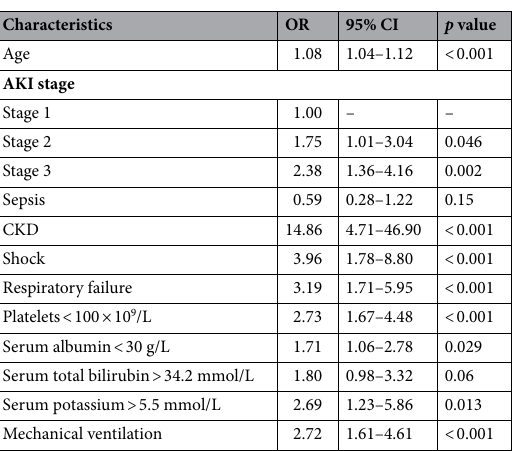
Table 4. Multivariable logistic regression analysis of risk factors associated with 90-day adverse outcomes. OR odds ratio, CI confidence interval, AKI acute kidney injury, CKD chronic kidney disease.